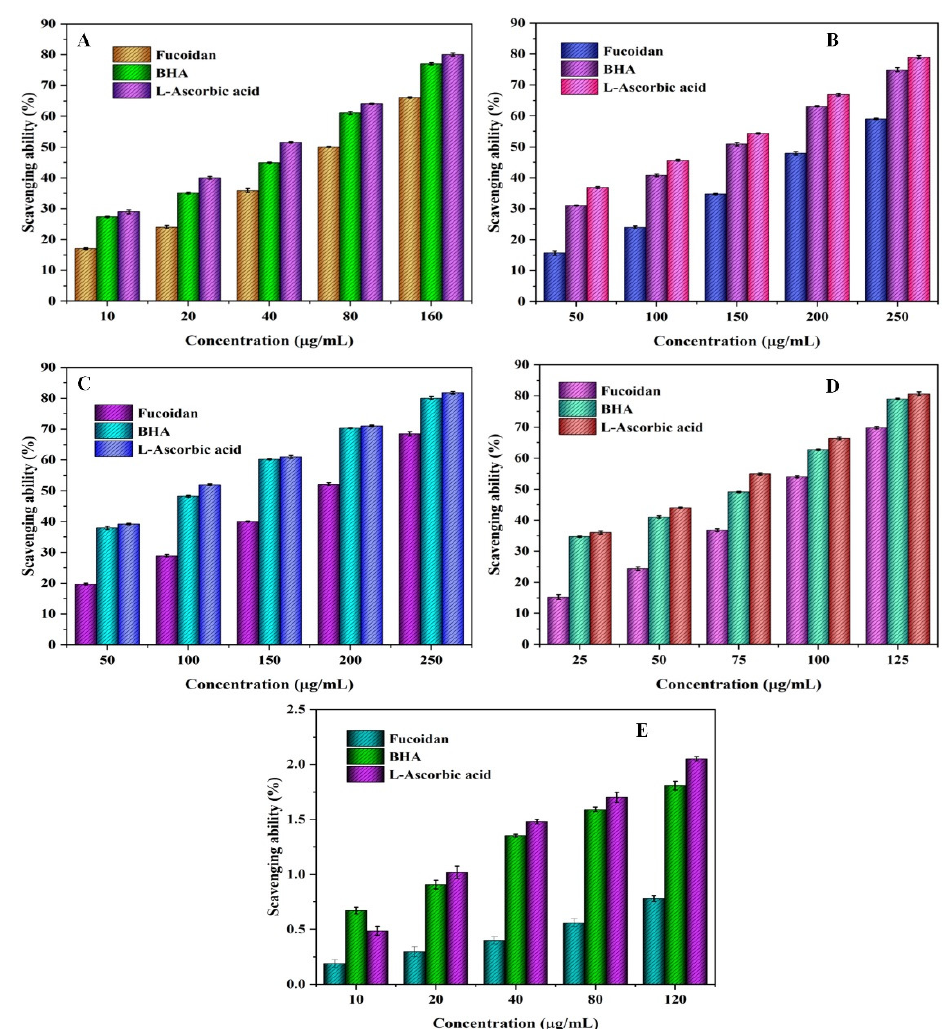
Figure 8. Antioxidant activity of fucoidan S. ilicifolium : ( A ) DPPH scavenging assay, ( B ) hydroxyl scavenging activity, ( C ) superoxide radical scavenging activity, ( D ) ABTS assay and ( E ) reducing power. Table 4. Anticoagulant activity of fucoidan from Sargassum ilicifolium .